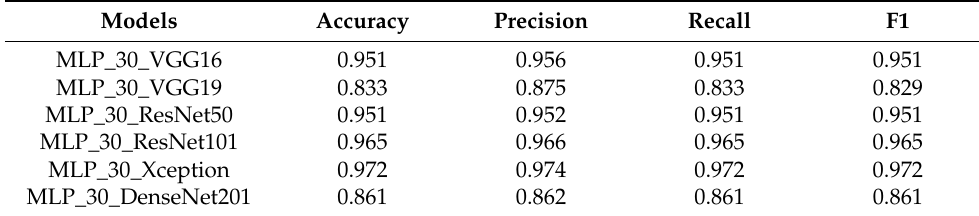
Table 5. The validation set results for six fusion models.